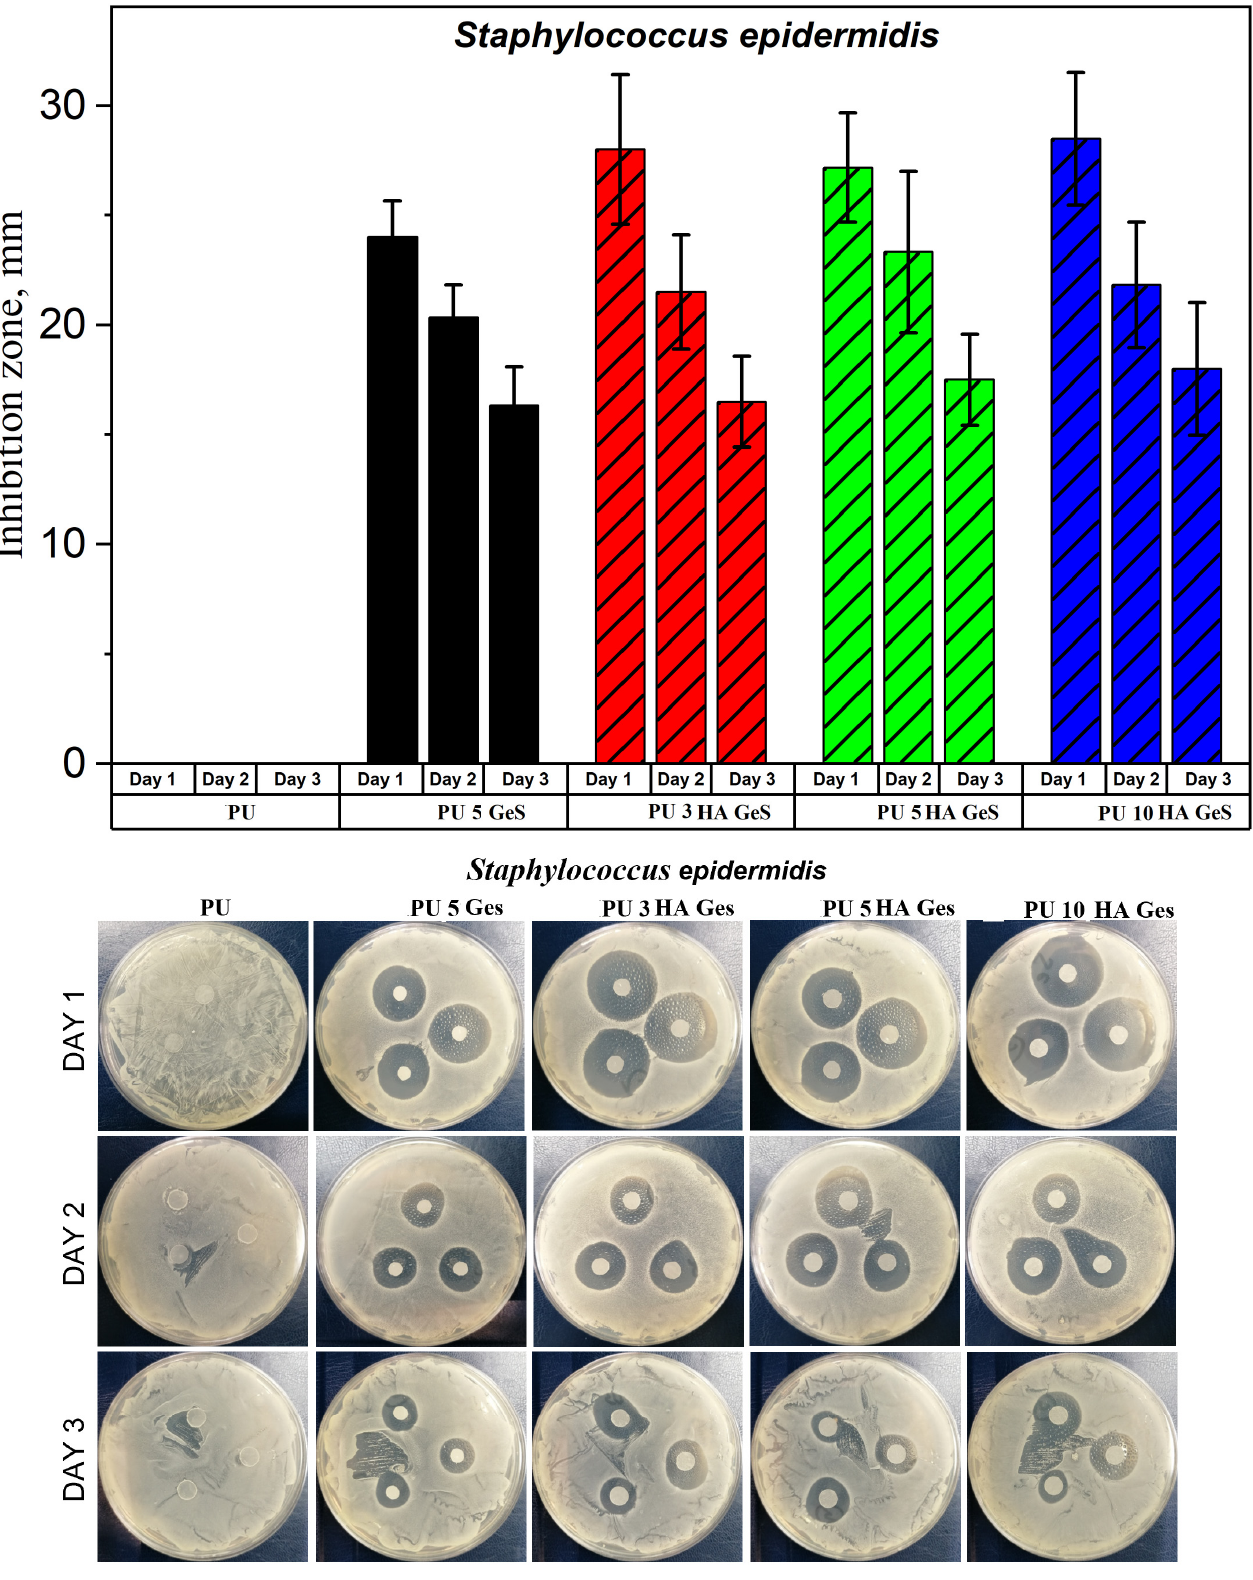
Figure 9. Inhibition zones of S. epidermis growth around nanocomposite-film discs.